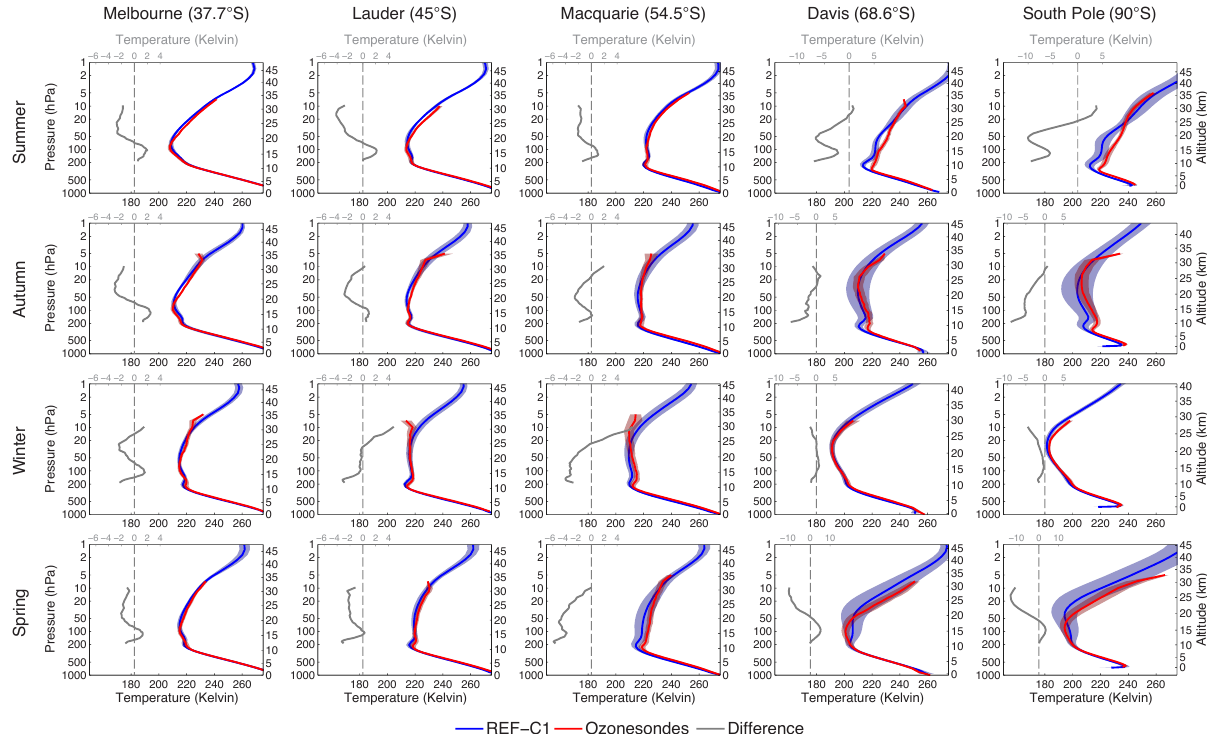
Figure 5. Same as Fig. 4, except for temperature. The grey lines show REF-C1 differences from ozonesondes, following the top x axis.